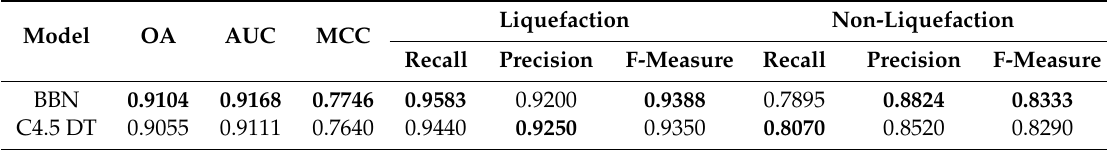
Table 5. Performance evaluation of the training dataset.